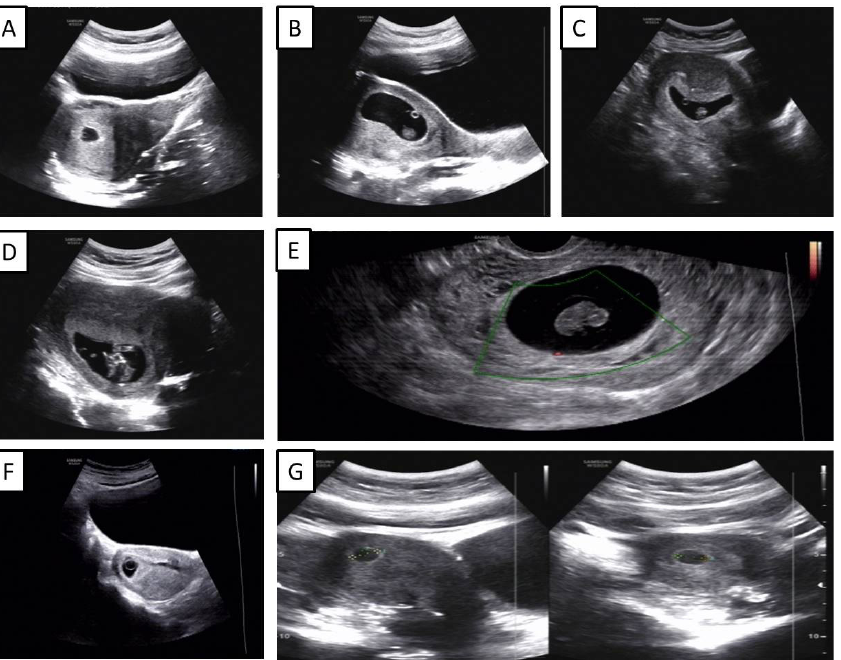
Figure 1 : Ultrasonography detection of yolk sac in pregnant women within 12 weeks of gestation . A: The yolk sac was observed under ultrasonography at 5 weeks of gestation. B, C: The yolk sac was observed under ultrasonography at 9 weeks of gestation. D: The yolk sac was not clearly showed under ultrasonography at 11+ weeks of gestation. E: The yolk sac was not clearly showed under ultrasonography at 6 weeks of gestation indicated embryo damage; F: The yolk sac is large with normal embryo undeveloped. G: The yolk sac was not clearly showed under ultrasonography at 6 weeks of gestation indicated embryo